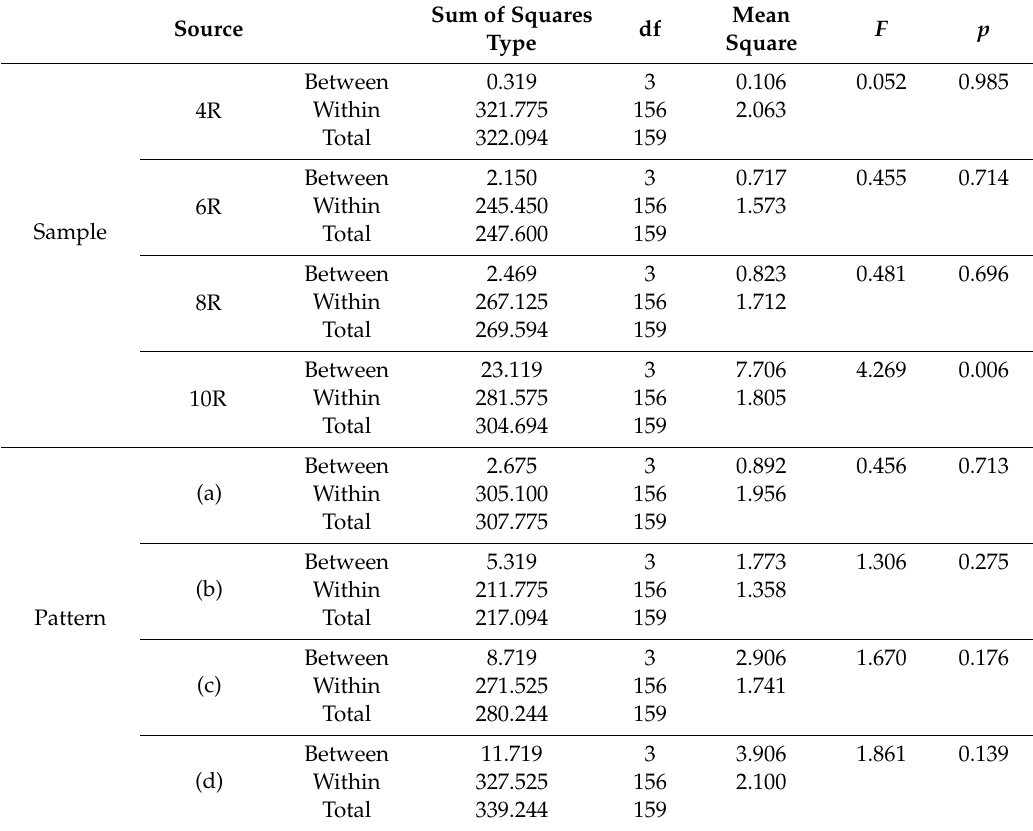
Table 6. Results of one-way ANOVA for grip comfort by each sample and usage pattern.